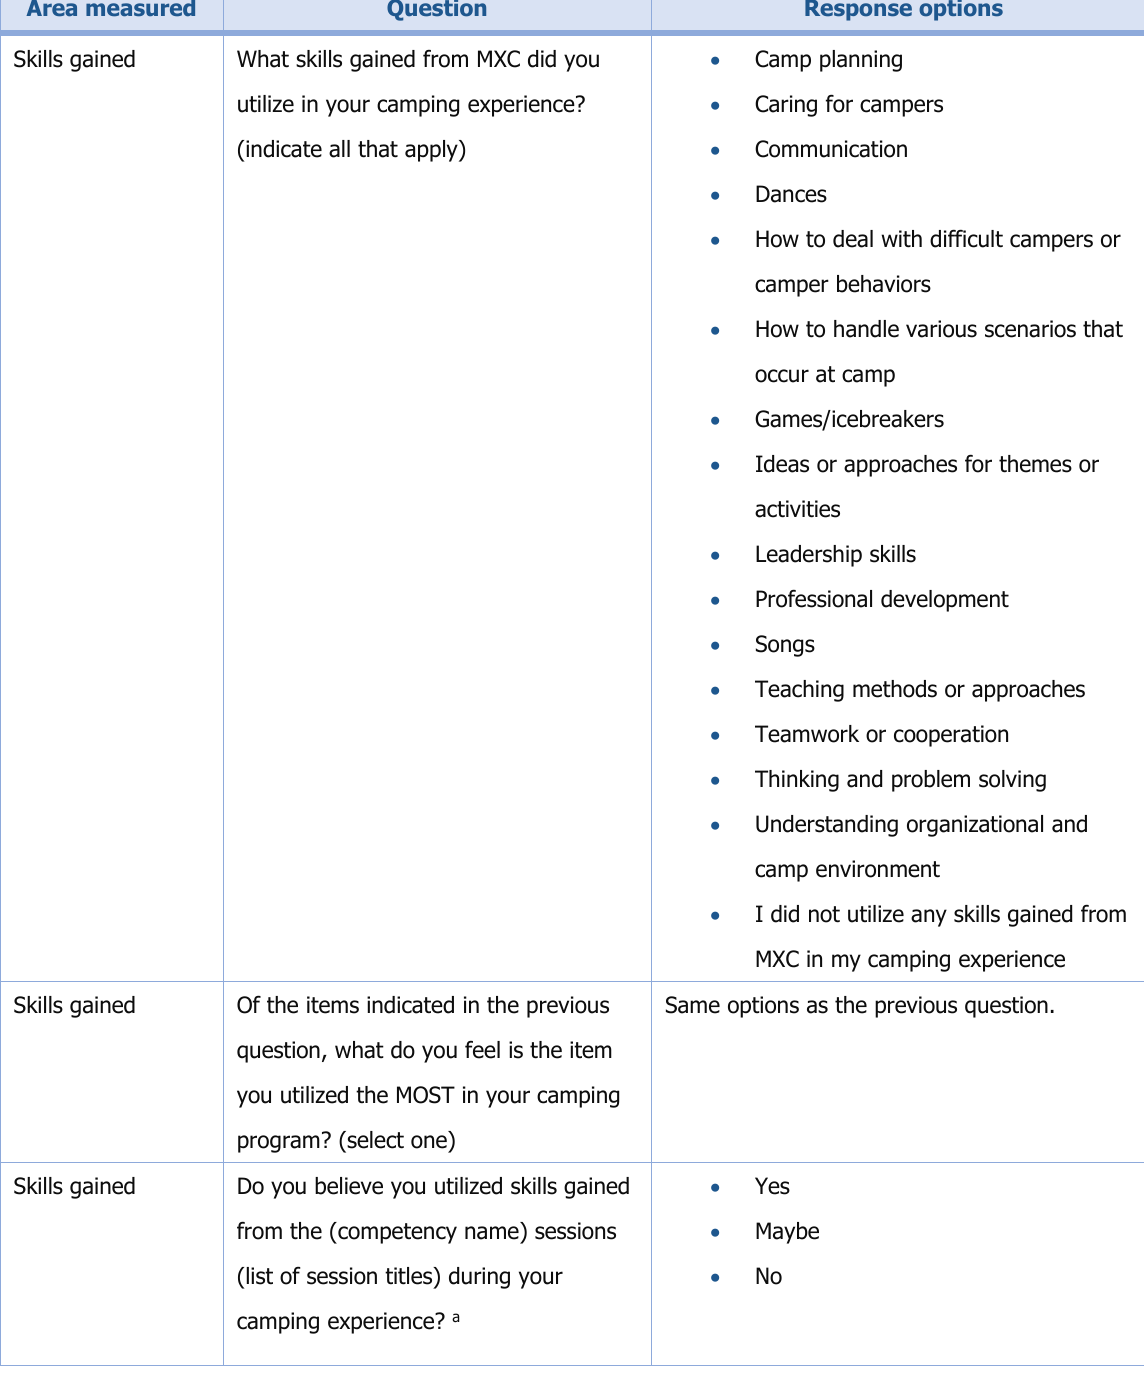
Table 5. Sample Questions and Response Formats for Camp Counselor Instrument Area